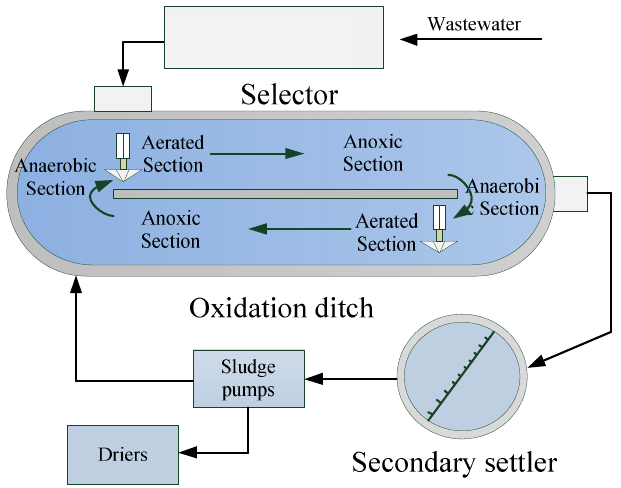
Figure 5. Schematic layout of a real full-scale wastewater treatment process (WWTP).